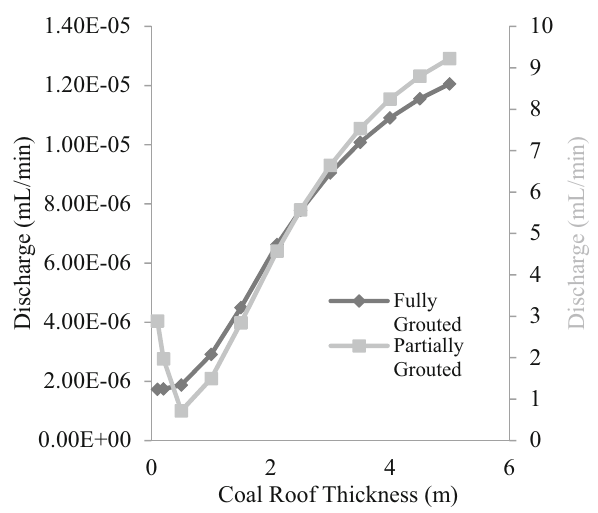
Fig. 5 Effects of coal roof thickness on groundwater discharge flow rates for fully grouted (dark) and partially grouted (light)